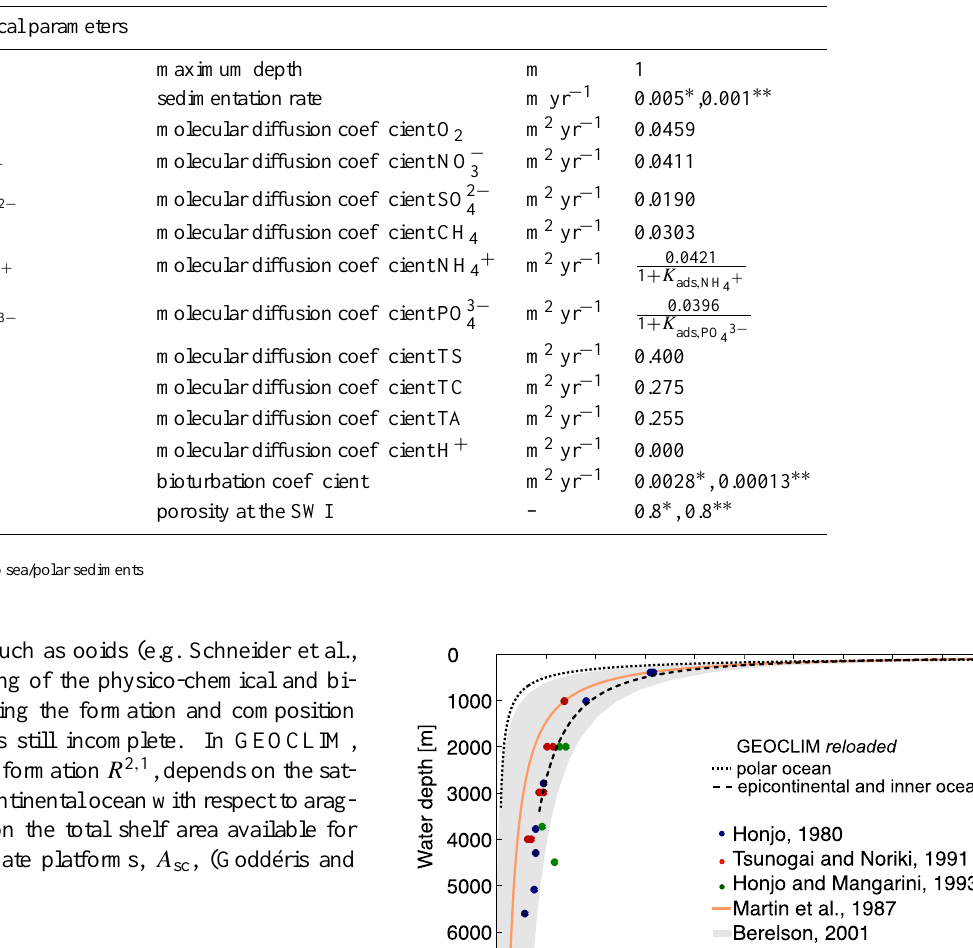
Table 7. Transport parameter values used in the diagenetic model.